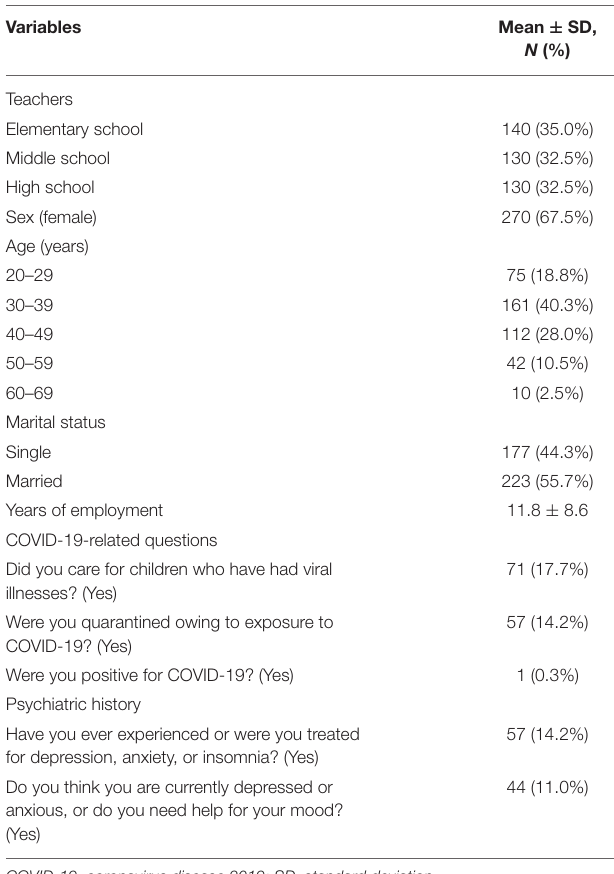
TABLE 1 | Demographic characteristics of the participants ( N =